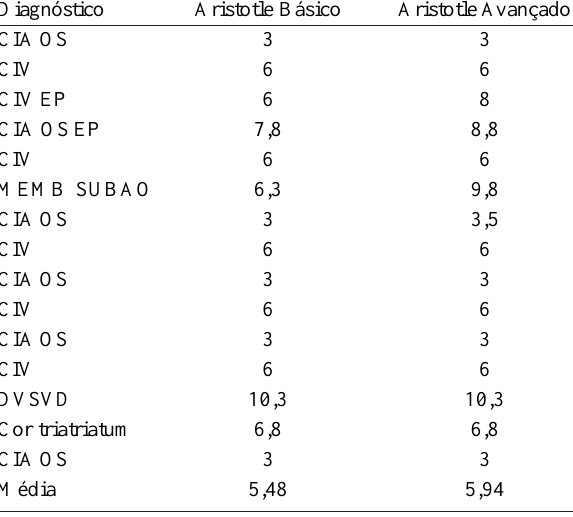
Tabela 3. Resultados do Escore de risco Aristotle, com os diagnósticos.